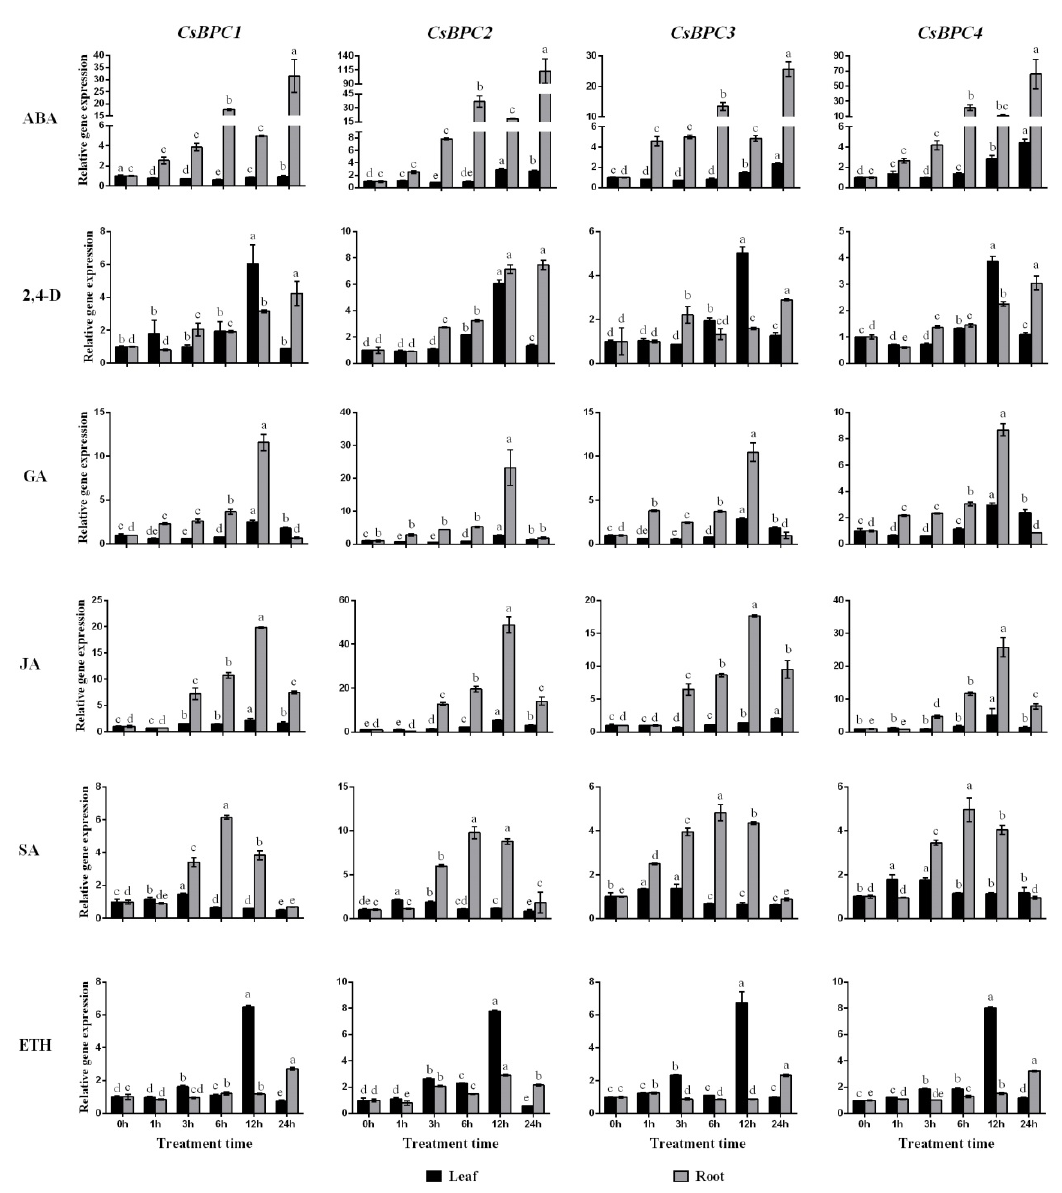
Figure 6. Expression patterns of CsBPC genes under di ff erent phytohormone treatments. Cucumber seedlings at three-leaf-stage were exposed to ABA, SA, JA, ETH, 2,4-D, and GA conditions, and qRT-PCR was performed to examine the transcript levels of CsBPCs in response to di ff erent phytohormones. The expression levels in non-stressed leaves and roots were set as 1. Values are means ± SD ( n = 3). Di ff erent letters indicate significant di ff erences ( p < 0.05).